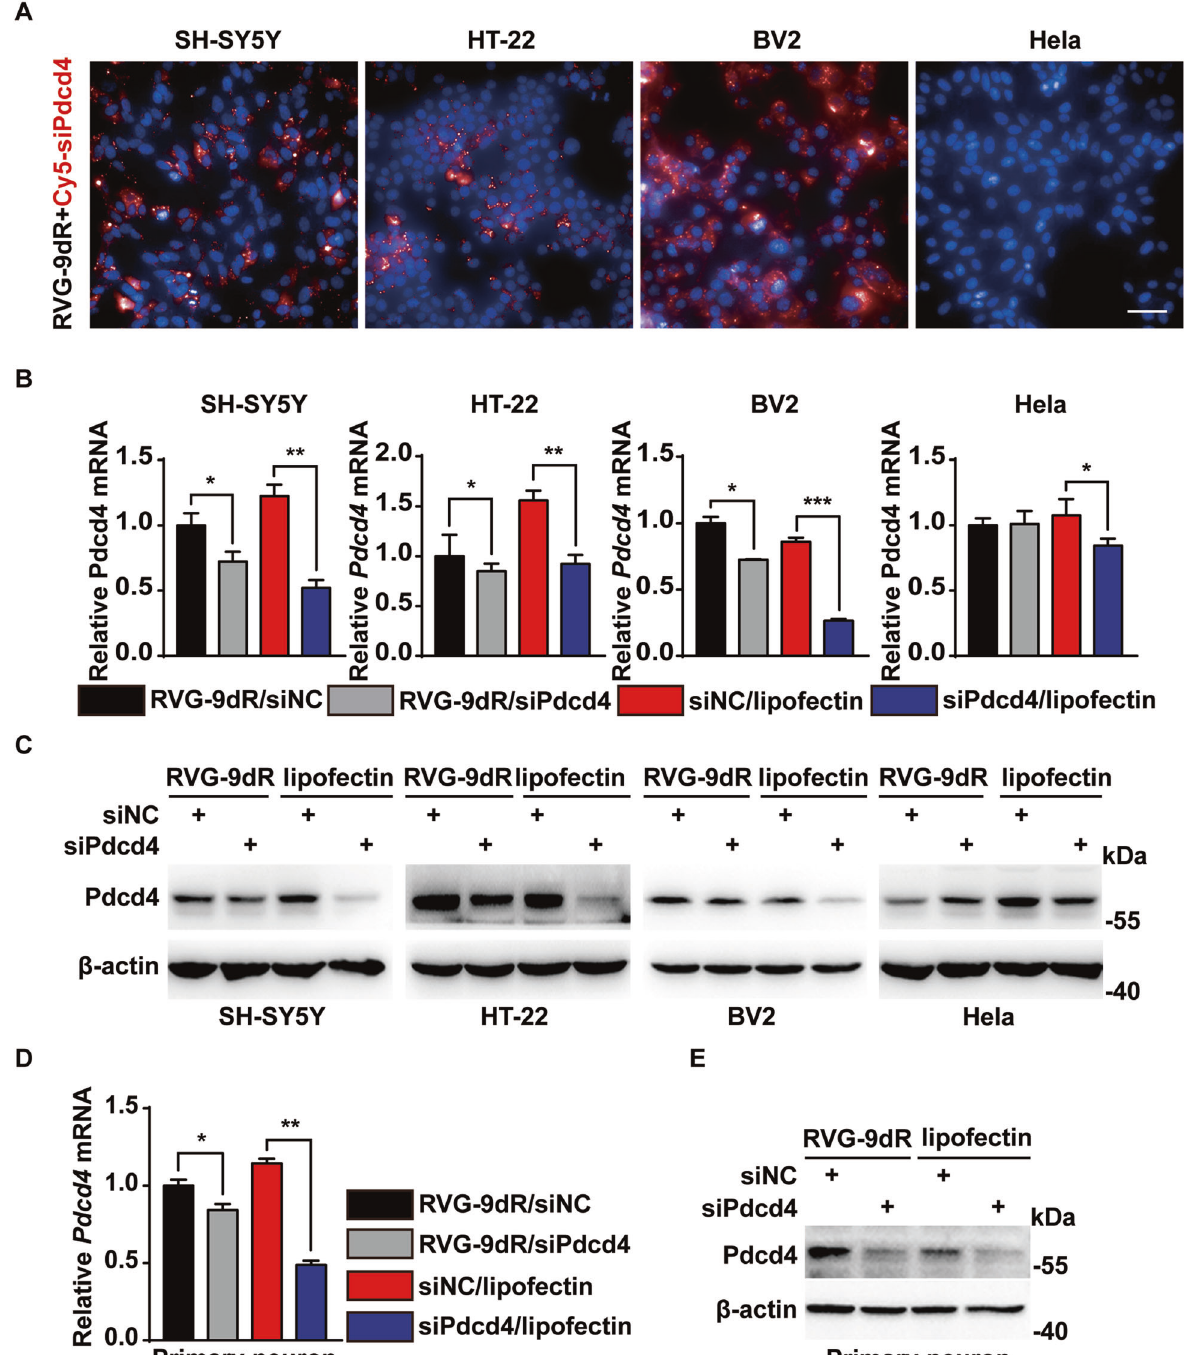
Fig. 2 RVG-9dR peptide allows delivery siPdcd4 into neuron and microglia. A The Cy5 fl uorescent-labeled RVG/siPdcd4 (RVG/Cy5-siPdcd4) was added to infect SH-SY5Y, HT-22, BV2 and Hela cells for 12 h, and the red fl uorescence distribution in cells were detected by high-content imaging system. As pictures shown DAPI staining (Blue) and Cy5-siPdcd4 (red). Scale bar, 50 μ m. B – E The cells (Hela, SH-SY5Y, HT-22, BV2, and primary neuron) were treated with RVG/siNC, RVG/siPdcd4 or lipofectamine/siRNA (100 pM siRNA per well) for 24 h, and the interference ef fi ciency of siPdcd4 were measured by RT-PCR ( n = 3 per group) and western blot. Values are indicated as mean ± SD, Student ’ s t test * p < 0.05, ** p < 0.01, *** p < 0.001. All the experiments were repeated at least three times suppresses the secretion of pro-in fl ammatory cytokines IL-6 and (Fig. 1d – g). According to the in fl ammation hypothesis of depression, microglia-mediated in fl ammatory response acceler- ates nerve damage in depression [25]. We tested the effect of Pdcd4 knockdown on the expression of in fl ammatory cytokines in microglia. The results showed that siPdcd4 signi fi cantly